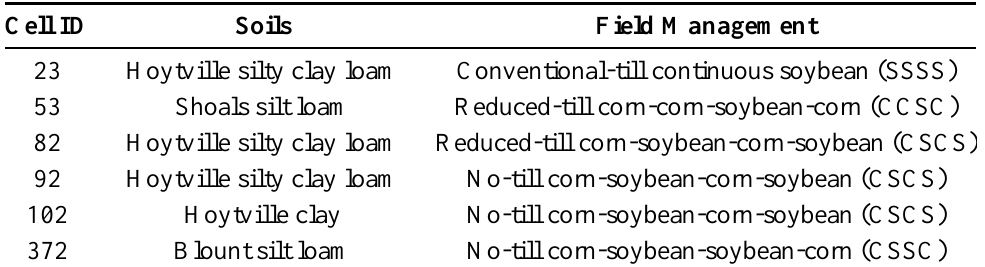
Table 8 . List of cells which in situ P were analyzed during simulation period and their soil type and land use during